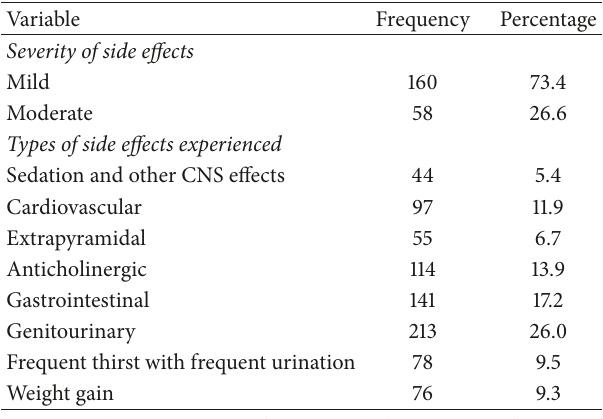
Table 6: Severity and types of side effects experienced by partici- pants.